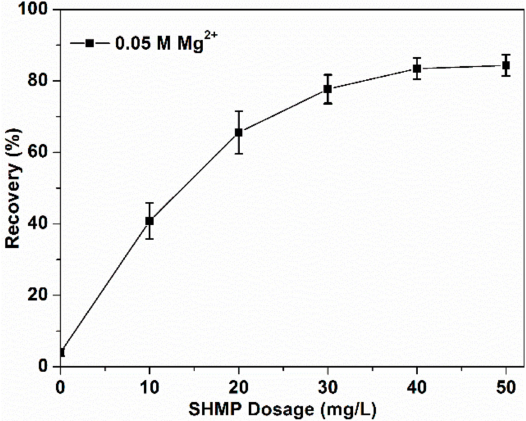
Figure 5. MoS 2 recovery as a function of SHMP dosage at pH 10.